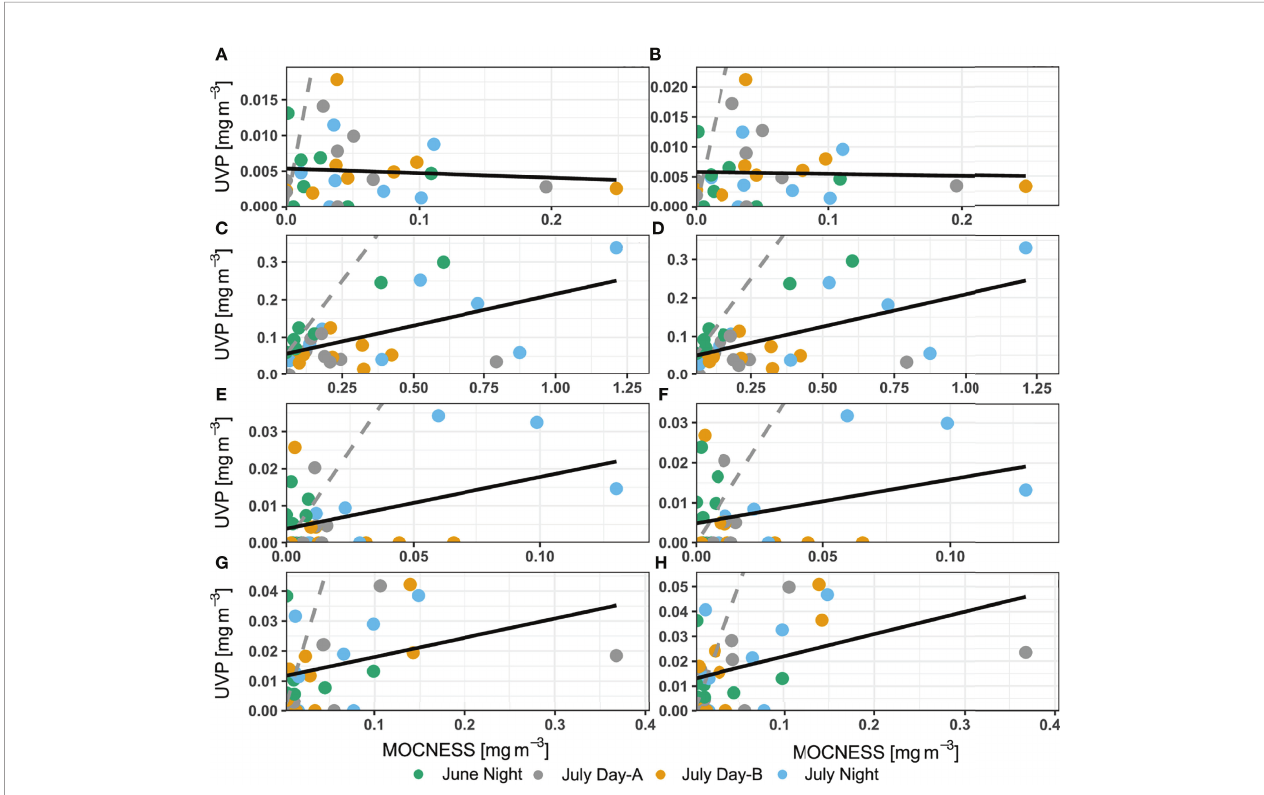
FIGURE 8 | Comparison of biomass concentration estimates between MOCNESS to (A, C, E, G) pooled-cast UVP method and between MOCNESS to (B, D, F, H) average-cast UVP method. Taxon-speci fi c regressions are for (A, B) chaetognaths, (C, D) copepods, (E, F) ostracods/cladocerans, and (G, H) shrimp-like crustaceans. Dotted grey line indicates 1:1 relationship while the solid grey line identi fi es the line of best fi t determined by ordinary least squares